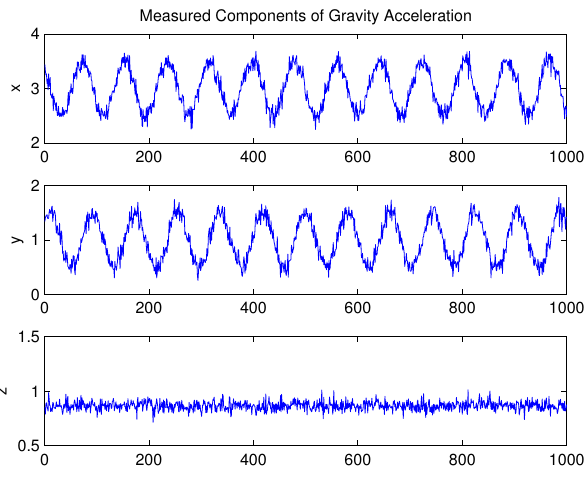
Figure 4. Measured components of gravity acceleration along three axis.